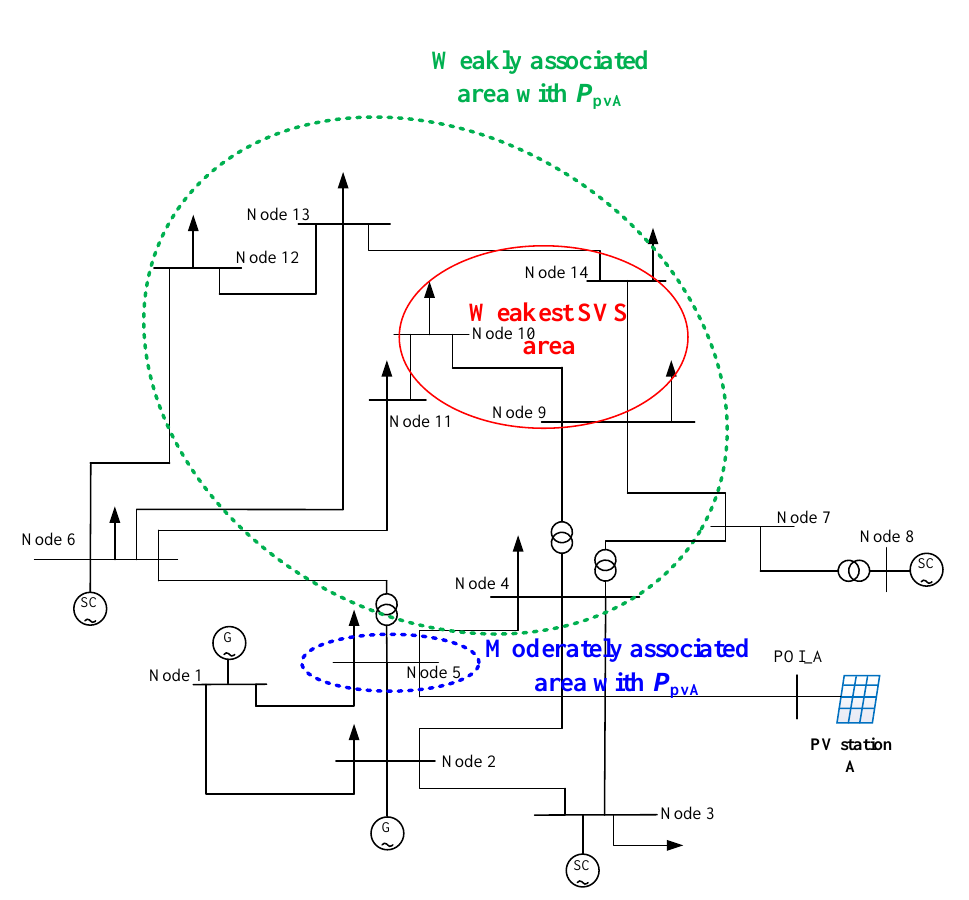
Figure 7. Static voltage stability zoning chart of Plan A.